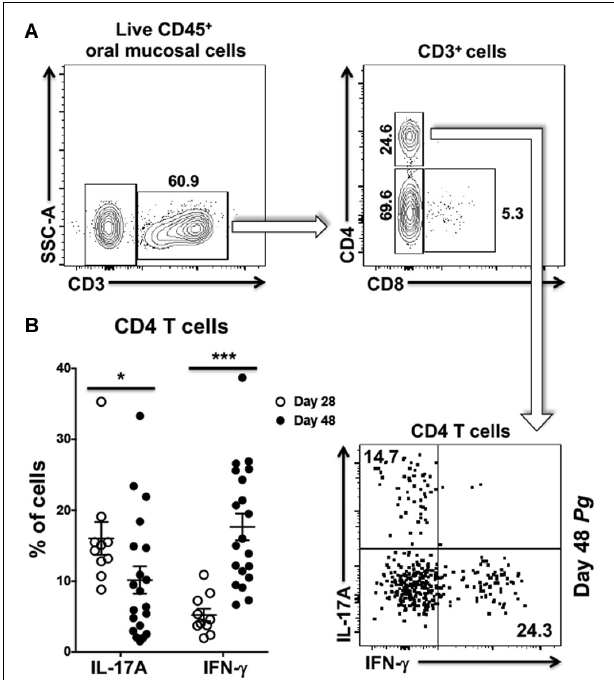
FIGURE 2 | Frequency of Th1 cells significantly increases within the oral mucosa of P. gingivalis inoculated mice by day 48. (A) Representative flow cytometry plots showing the gating strategy used to identify Th1 (IFN- γ + ) and Th17 (IL-17A + ) cells within the oral mucosa. Numbers alongside gates indicate% of cells within that gate. (B) Summary data showing individual data points from three experiments examining the frequency of Th1 and Th17 recovered from the oral mucosa of mice at day 28 and day 48. Means ± SEM are plotted. Groups were compared with two-tailed Student’s t -test. * p < 0.05, *** p <